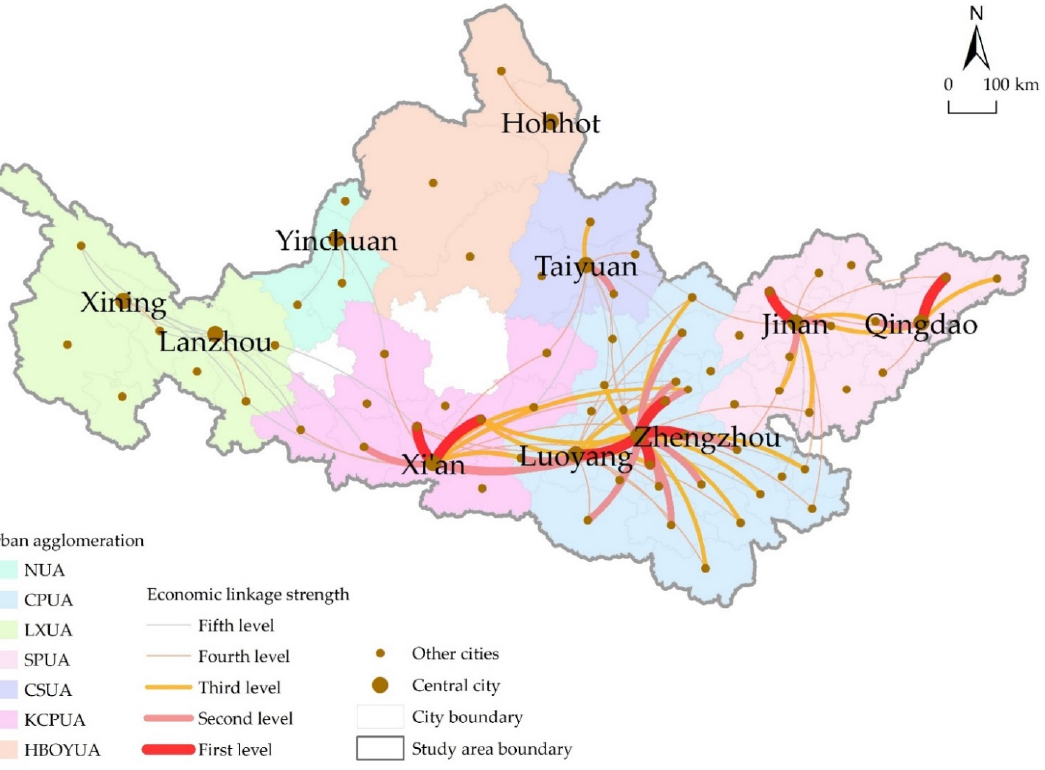
Figure 6. The 3 h HSR travel space links among the central cities and other cities.